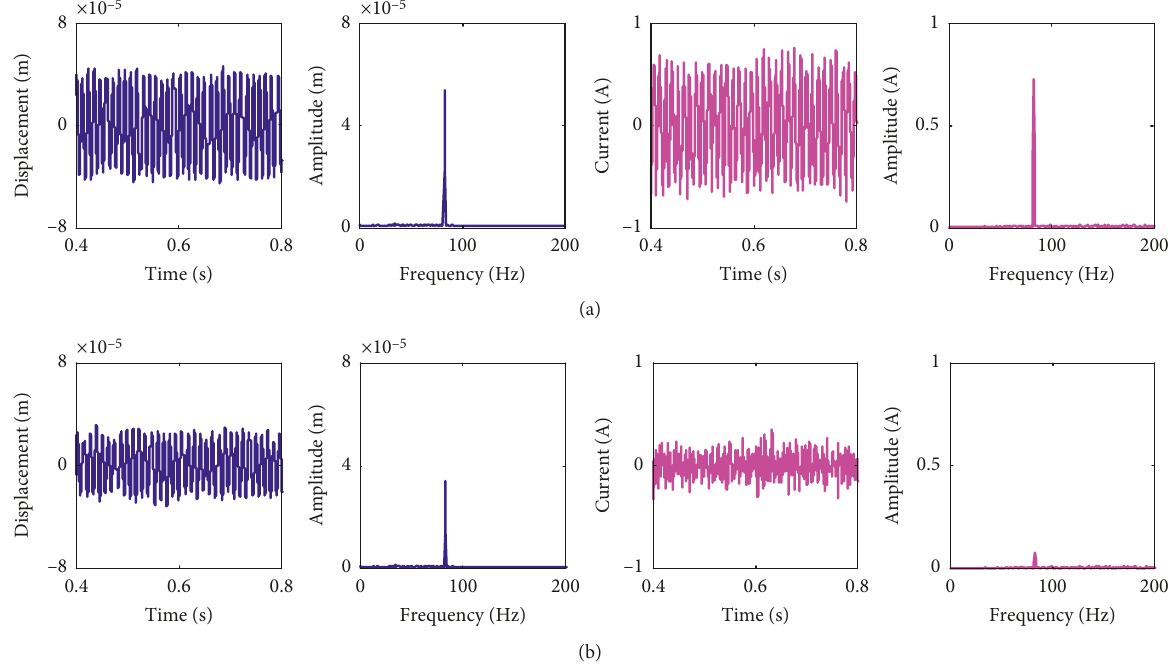
Figure 8: Comparison of vibration response at 5000rpm (a) without unbalance control and (b) with unbalance corresponding synchronous control current is kept at a the vibration displacement of the rotor and the corre- very low level, less than 0.2 A. It ensures that the power sponding synchronous control current do not increase amplifier does not saturate due to excessive synchronous obviously as the rotational speed increases when the control current. The stability of the AMB-rotor system can imbalance control method is applied. Synchronous vi- be guaranteed. bration displacement remains within 3 × 10 − 5 m, and the